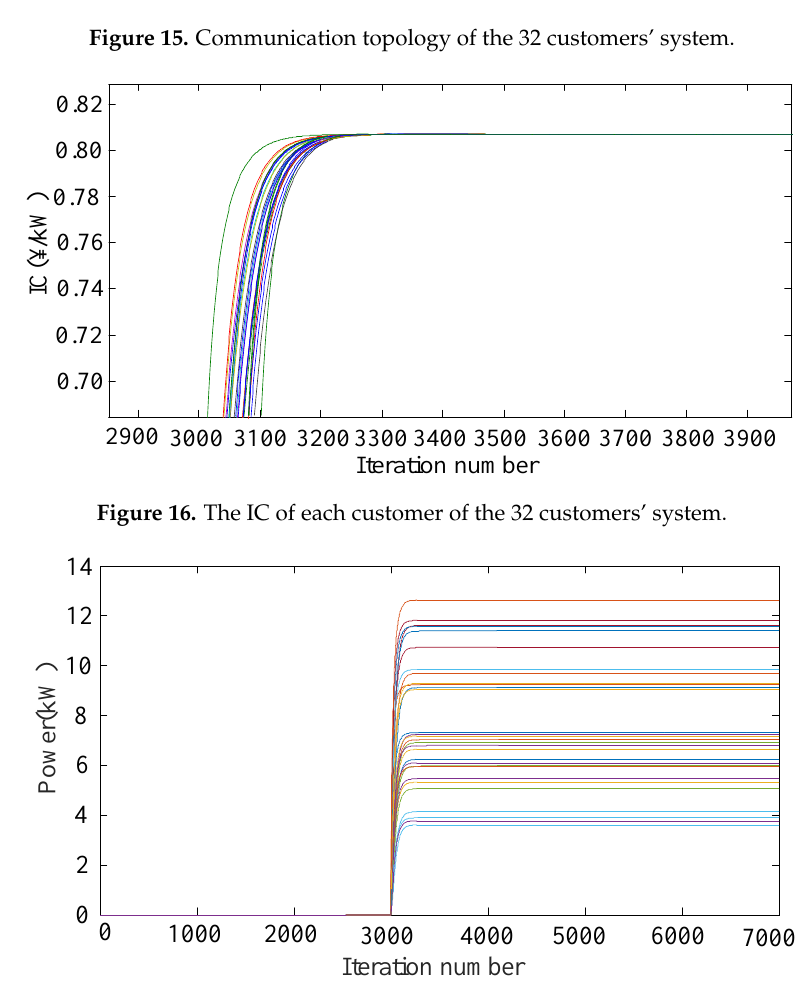
Figure 17. The power of each customer of the 32 customers ’ system.